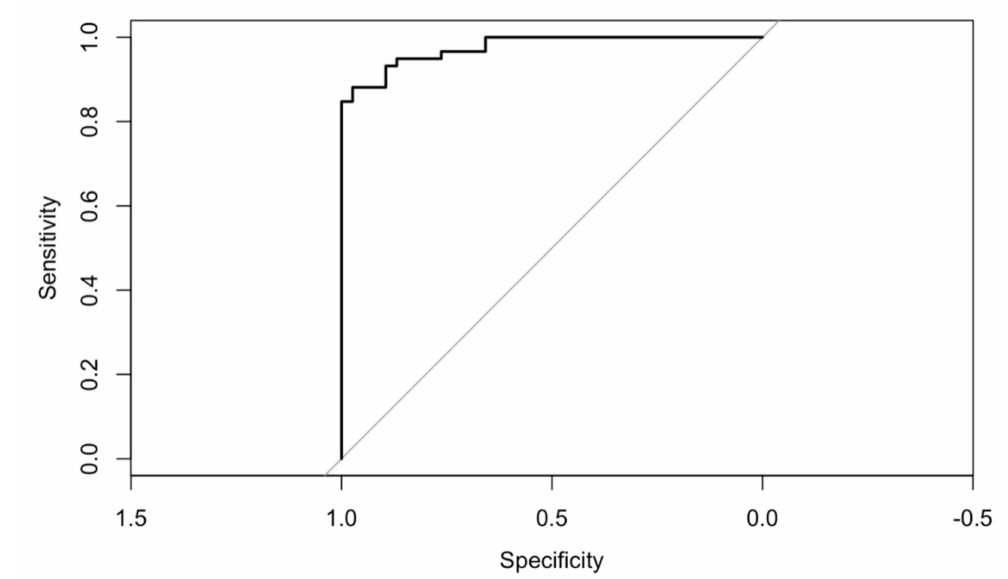
Figure 7. ROC curve. Radial Basis Neural